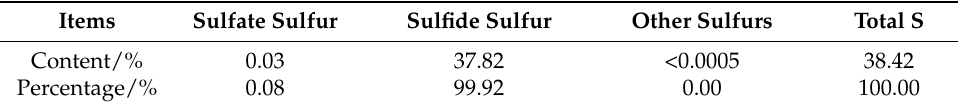
Table 2. Sulfur phases in the gold concentrate samples.